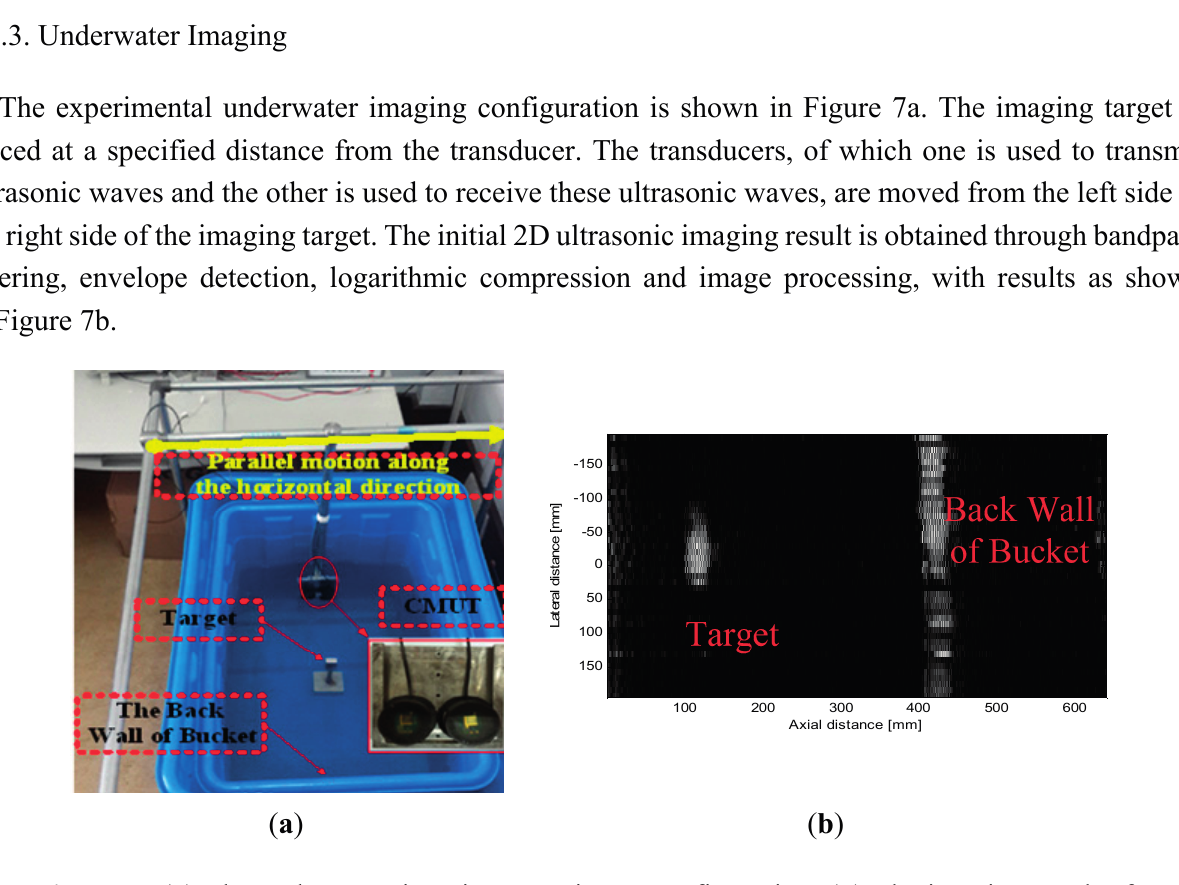
Figure 7. ( a ) The underwater imaging experiment configuration; ( b ) The imaging result of the